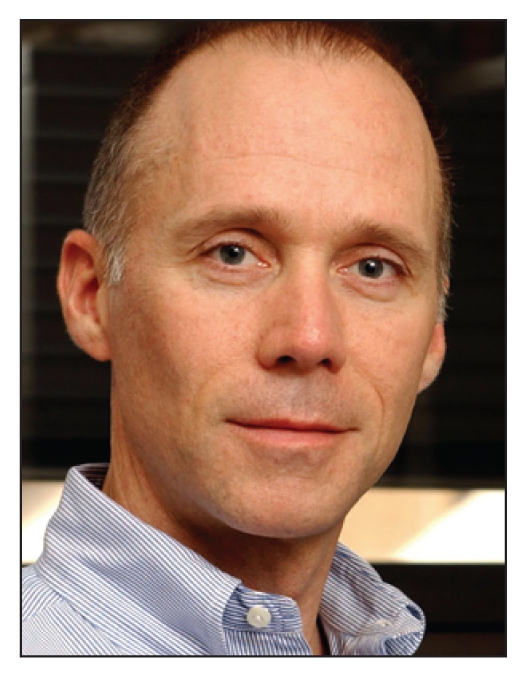
Matthew Longnecker